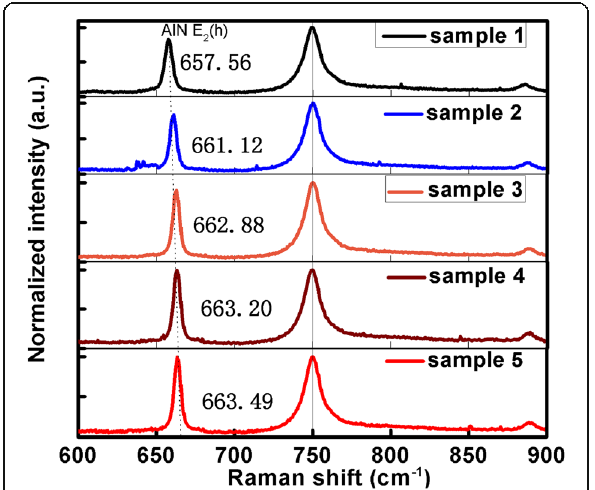
Fig. 5 Raman shift spectra of the five samples